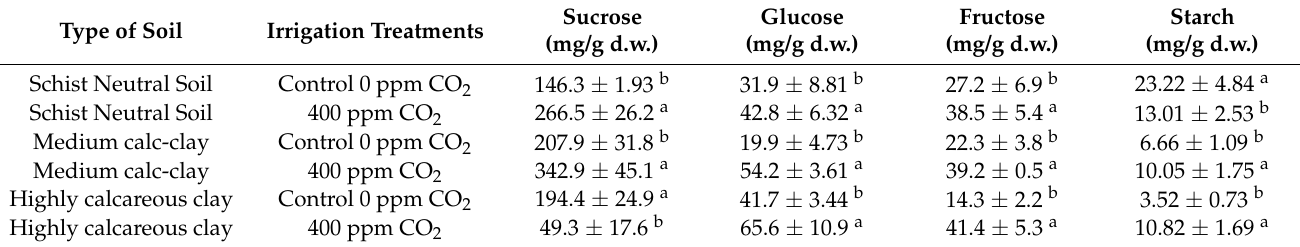
Table 6. Quantitation of sucrose, glucose, fructose, and starch in harvest leaves of V. vinifera (L.) cv. Tempranillo. Plants in pots with three different substrates. Treatments: schist soil, medium calcareous clay soil (medium calc-clay), and highly calcareous clay soil, treated with non-acidified water (control pH 7.5) and 400 ppm CO 2 -acidified water (pH 6.5). a,b : different letters denote a